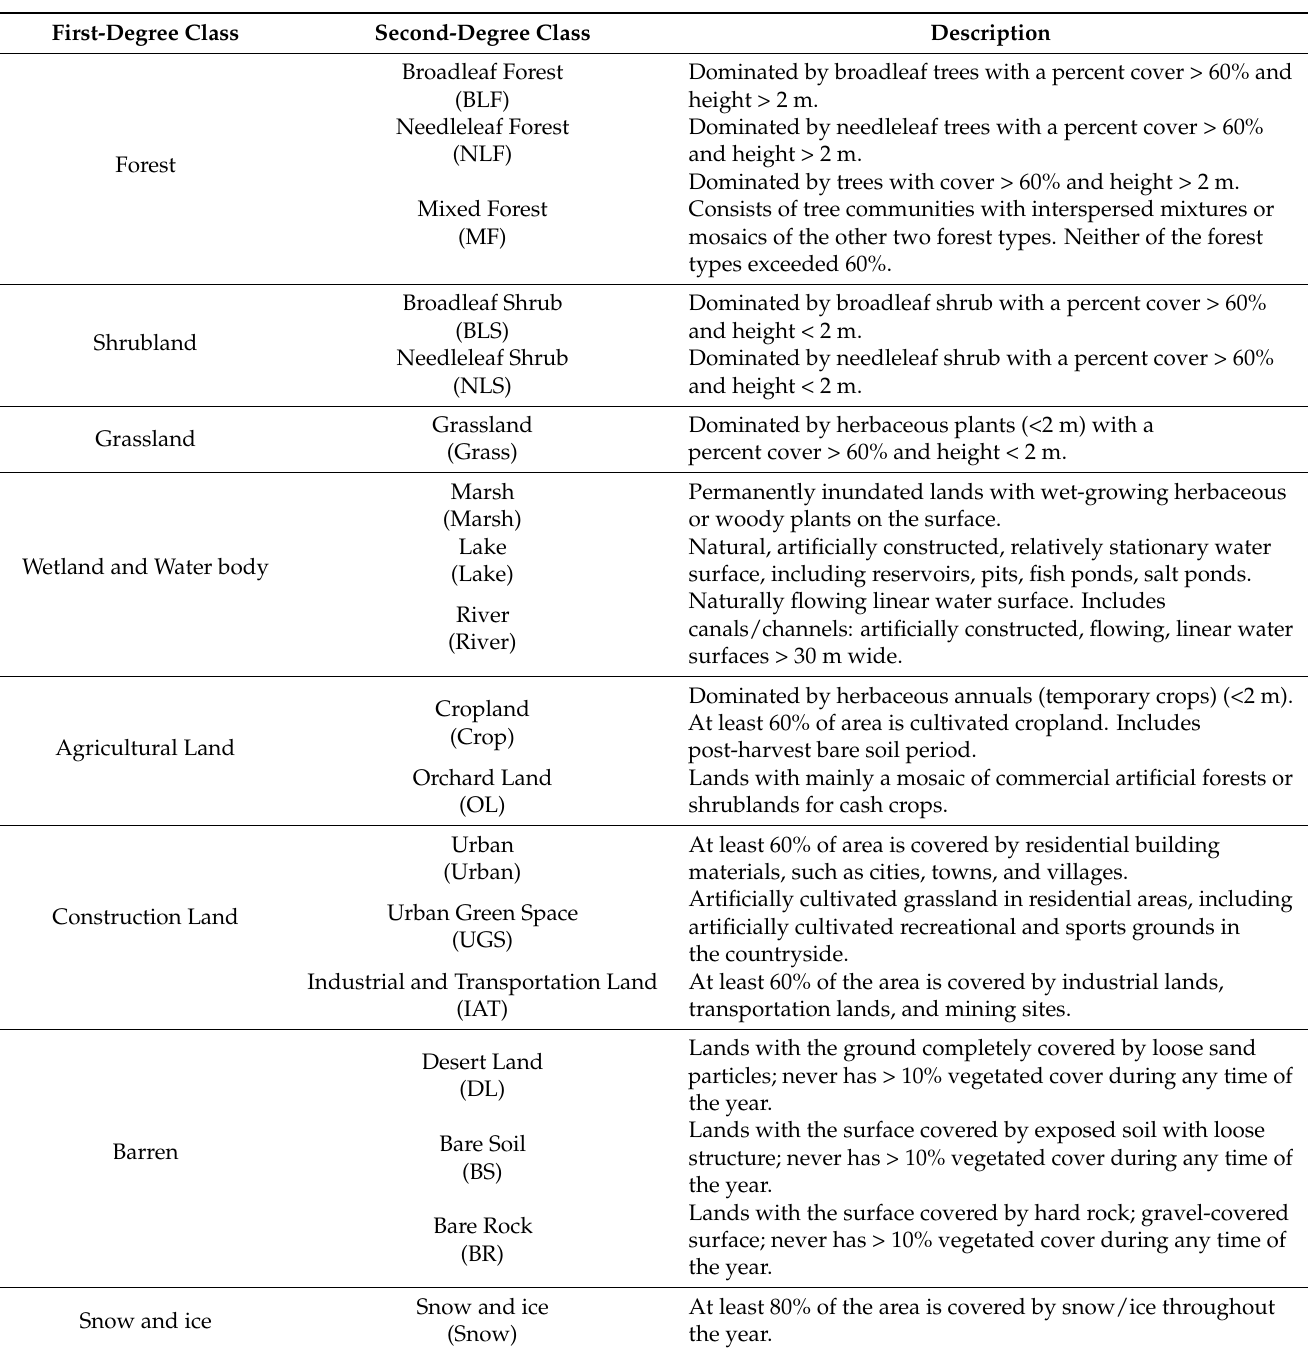
Table 2. The LULC classification scheme of this